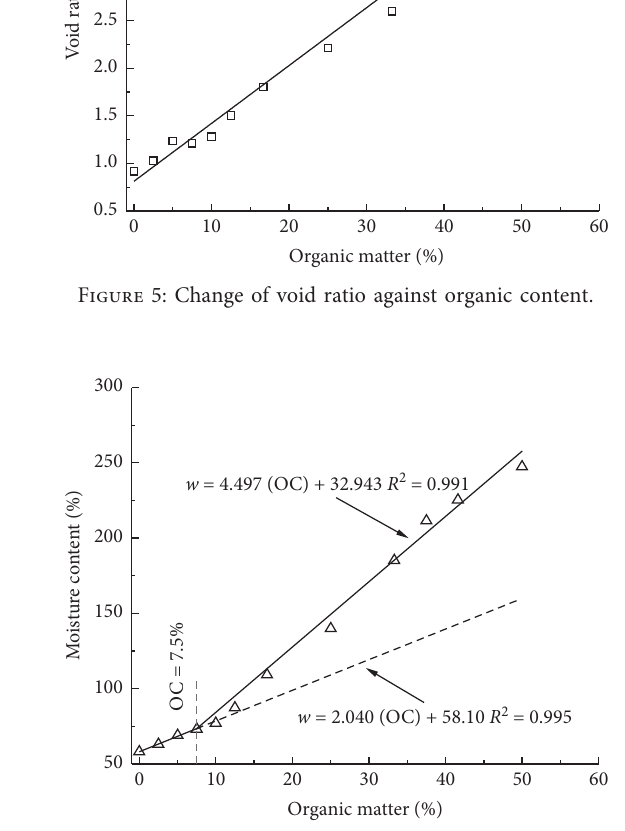
Figure 6: Change of moisture content against organic content.